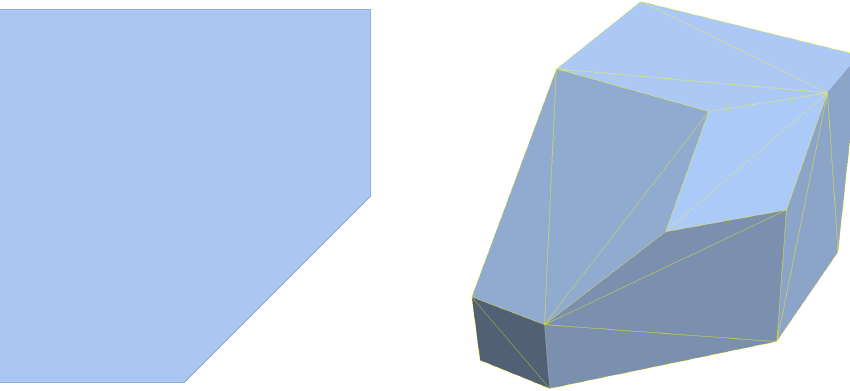
Figure 20. Cluster polytopes corresponding to A 2 (left) and A 3